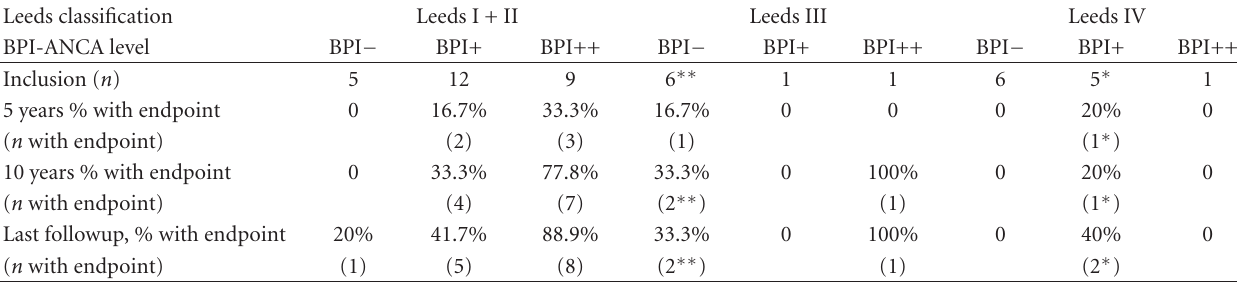
Table 2: PsA colonization, BPI-ANCA, and outcome. Adult CF-patients divided into groups based on Leeds classification and IgA BPI- ANCA levels at baseline and subsequent endpoints during